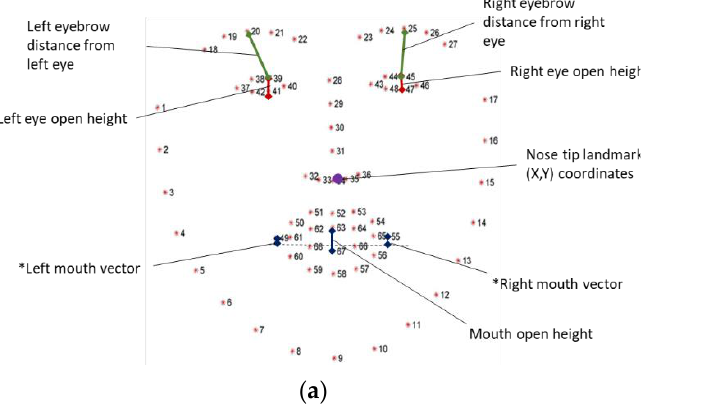
Figure 4. The 68 facial landmark points detected by the Dlib-based model: ( a ) features used for face image classification; ( b ) how the left mouth vector (OS’) and the right mouth vector (OR’) calculation. * features are calculated with P, Q, R, and S points (52, 58, 55, and 49 landmark points, respectively).